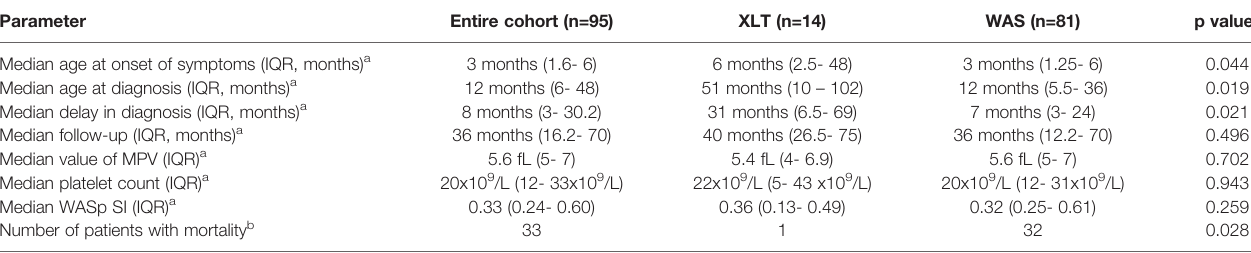
TABLE 1 | Baseline characteristics of the included patients. Parameter